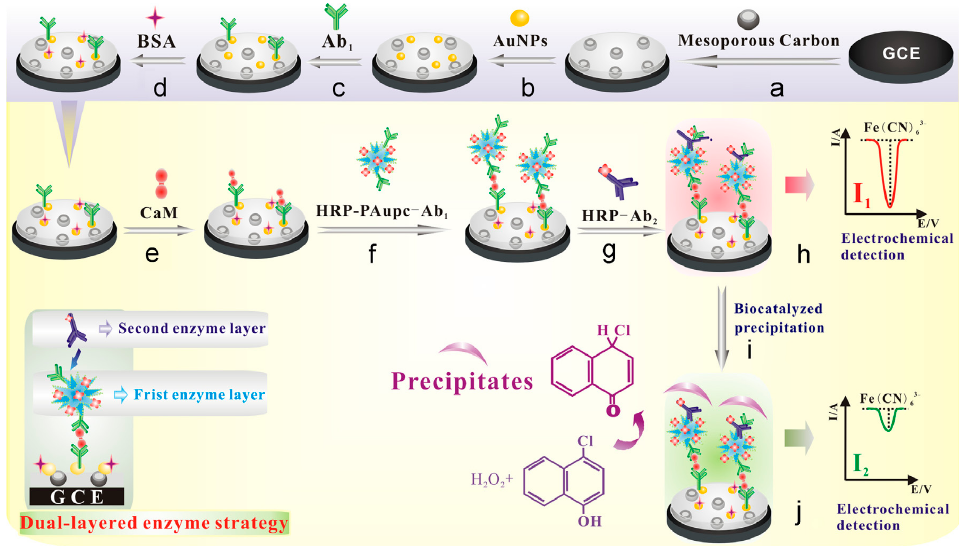
Figure 14. Schematic representation of an electrochemical immunosensor for calmodulin (CaM) based on enhanced biocatalyzed precipitation adopting a dual-layered enzyme strategy using a glassy carbon electrode (GCE) successively covered with mesoporous carbon, gold nanoparticles (AuNPs), Ab 1 antibody, bovine serum albumin (BSA), the CaM target, horseradish peroxidase and Ab 1 antigen covalently bound to poly(acrylic acid)-functionalized Au popcorn (HRP-PAupc-Ab 1 ) and horseradish peroxidase-secondary antobody (HRP-Ab 2 ) (reproduced from [250]).